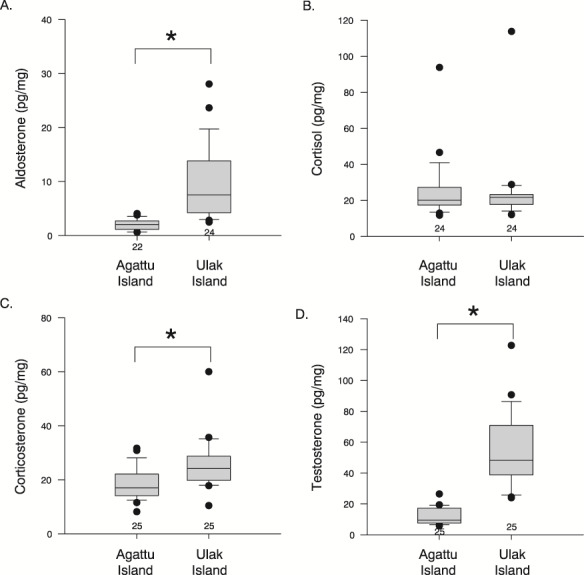
Concentrations of (A) aldosterone, (B) cortisol, (C) corticosterone, and (D) testosterone in Steller sea lion pups. There were no differences in hormone concentrations amongst male and female pups. Significant differences between rookeries are denoted by * and sample size noted on graphs. Box plot: grey box includes data between the 25th and 75th percentile, with a line within each box denoting the median, the whiskers denote the error bars (10 and 90% percentile), and the circles denote outliers